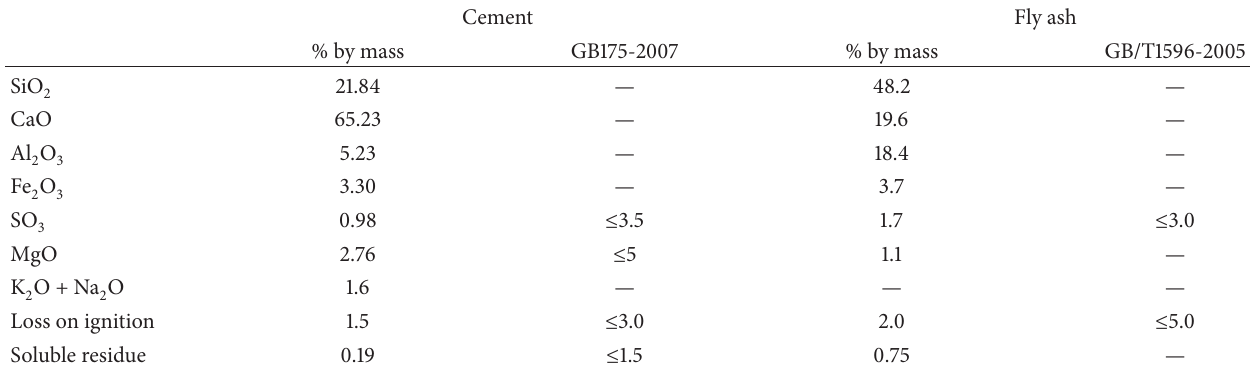
Table 1: Chemical properties of the cement and the fly ash that were used. Cement Fly